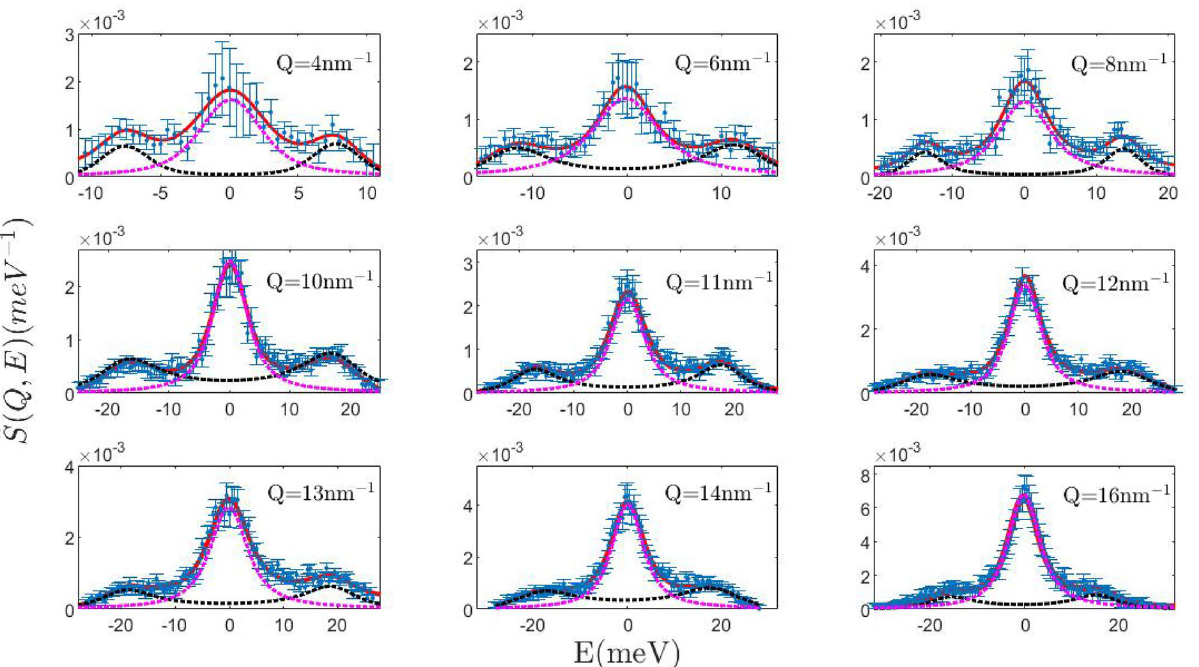
Figure 1. Dynamic structure factor of silver at nine selected Q values. The experimental data points are affected by resolution broadening. The corresponding fit obtained by the MCMC-RJ algorithm (solid red line) has been carried out considering the detailed balance asymmetry and finite resolution. The pink and the black dotted lines are the Lorentzian and DHO component respectively.